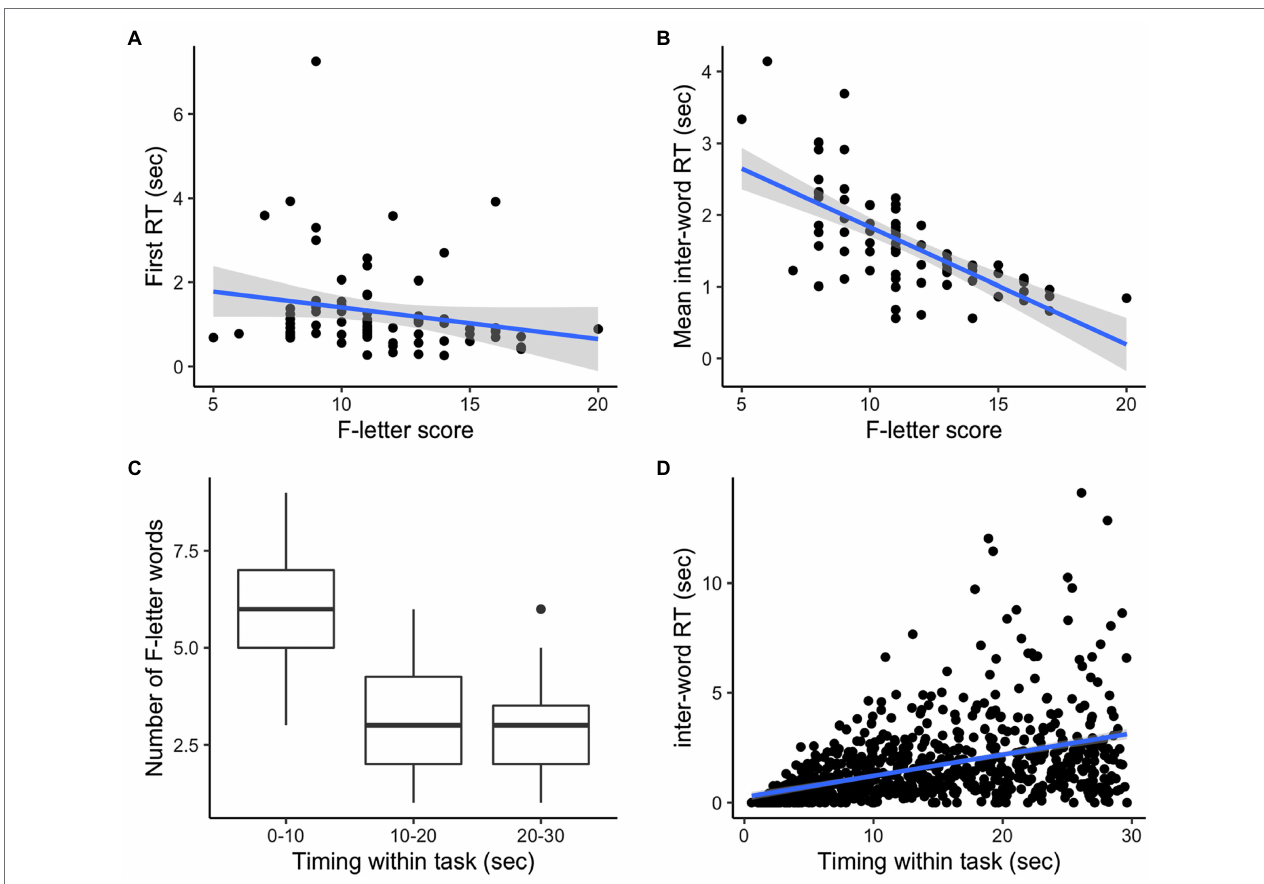
FIGURE 1 | Relations of F-letter performance, RT, and timing within